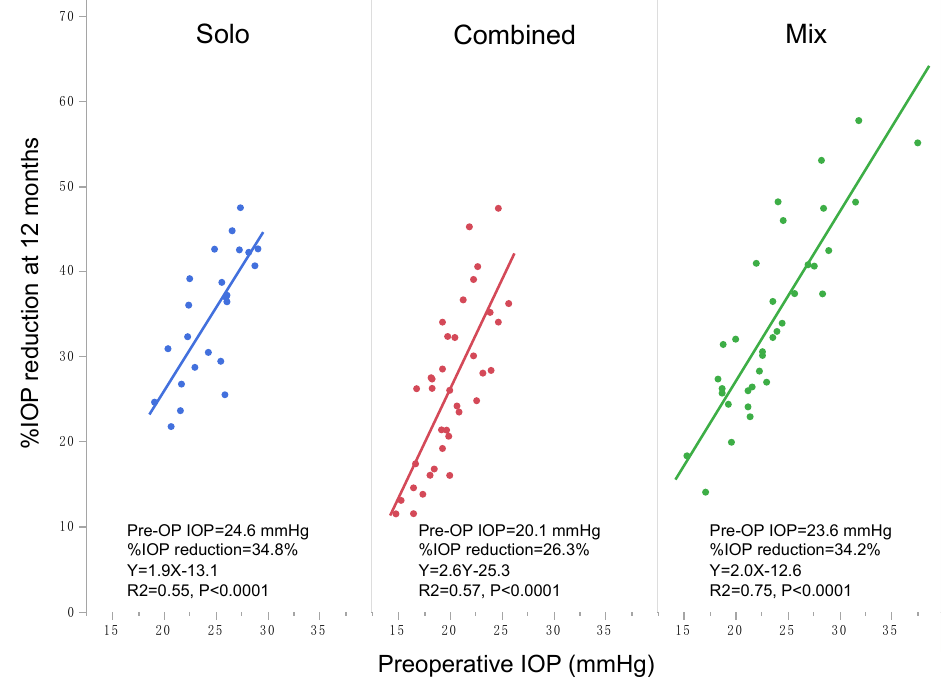
Figure 4. Correlation between preoperative and postoperative 12 months IOP after solo, combined, or both solo and combined ab interno goniotomy procedures in the published literature. Each line and area indicate linear regression and 95% confidence intervals,